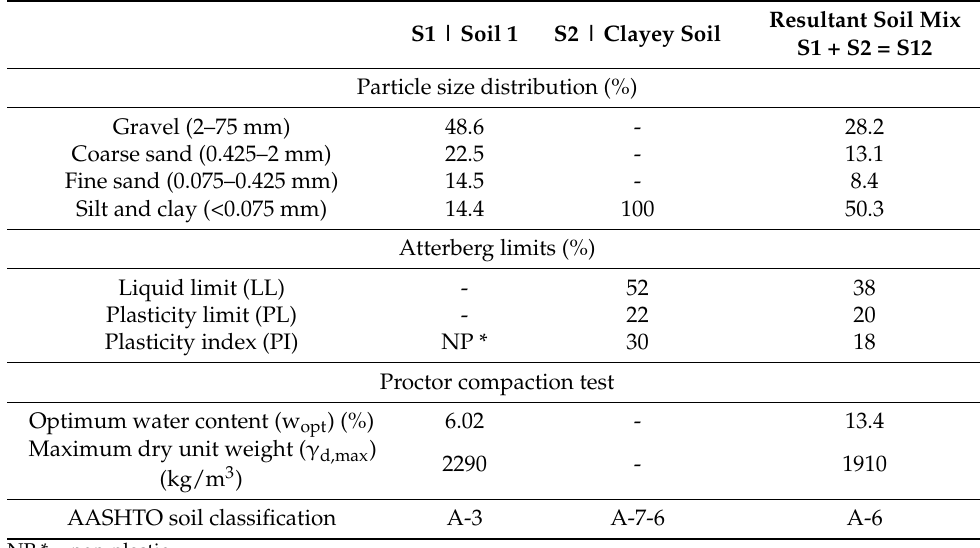
Table 2. Properties of soils used for the